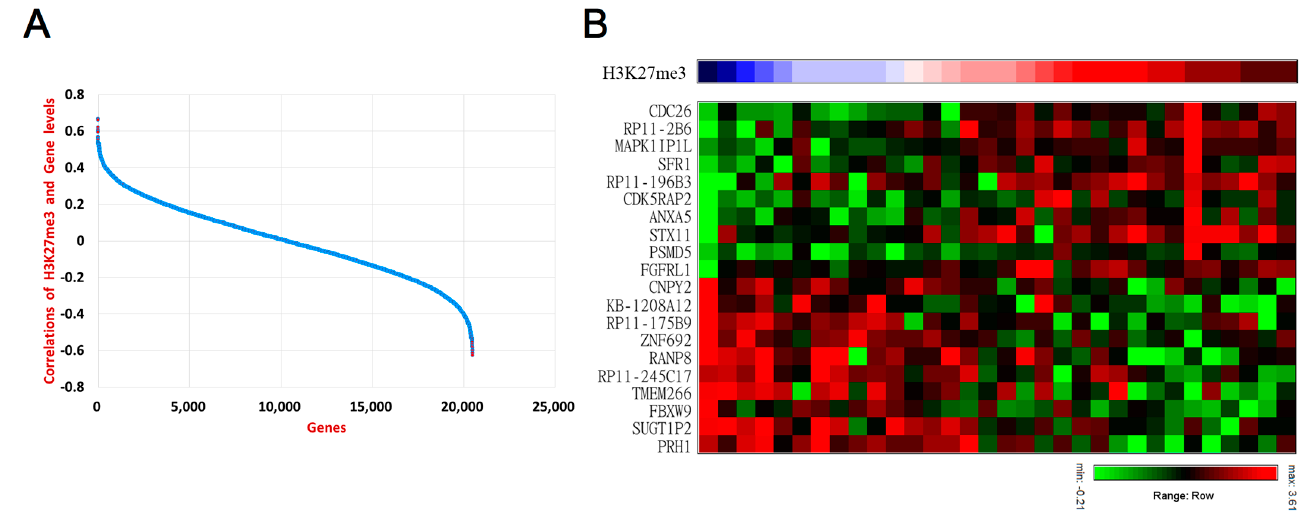
Figure 3. A screening of genes correlated with PRC2 abundance in UTUC. ( A ) Pearson’s correlations of H3K27me3 and transcriptomics. ( B ) Genes with the highest positive and negative correlations with H3K27me3 abundances.